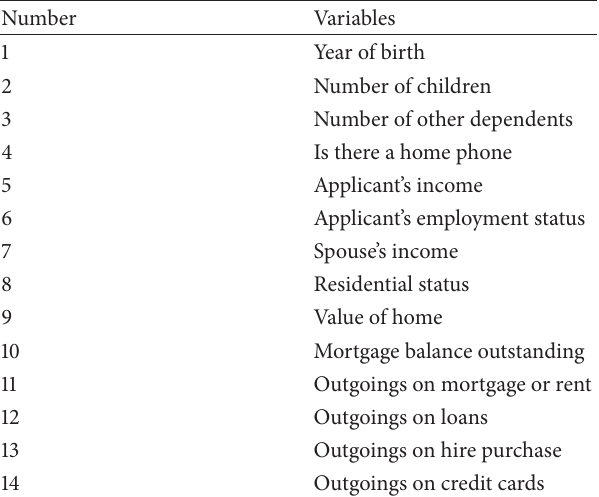
Table 1: Variables of the